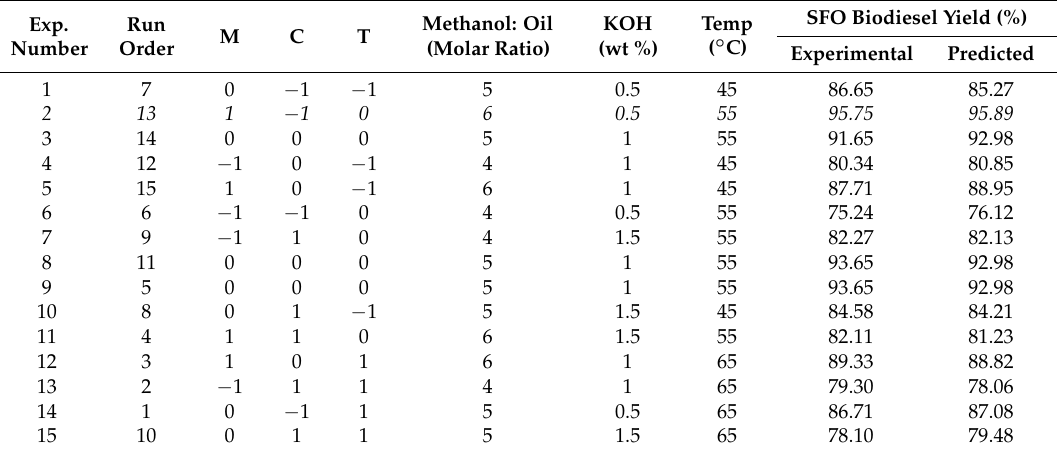
Table 7. Experimental matrix and results for Box-Behnken design model. The combination in italics shows the best combination for SFO biodiesel production.